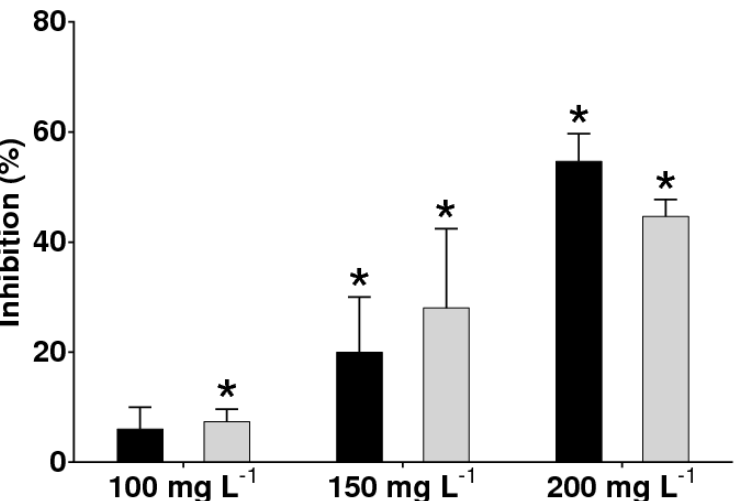
Figure 4. Antifungal activity of the extracts obtained from the endophytic fungi Bl1 (black bars) and Ech4 (grey bars) against B. cinerea. Each bar represents the average inhibition percentage of B. cinerea cultured in three experiments per treatment ± SD. Statistical significance when comparing treated groups and control group by multiple t-tests and Holm-Sidak method are indicated with asterisks ( p < 0.05).